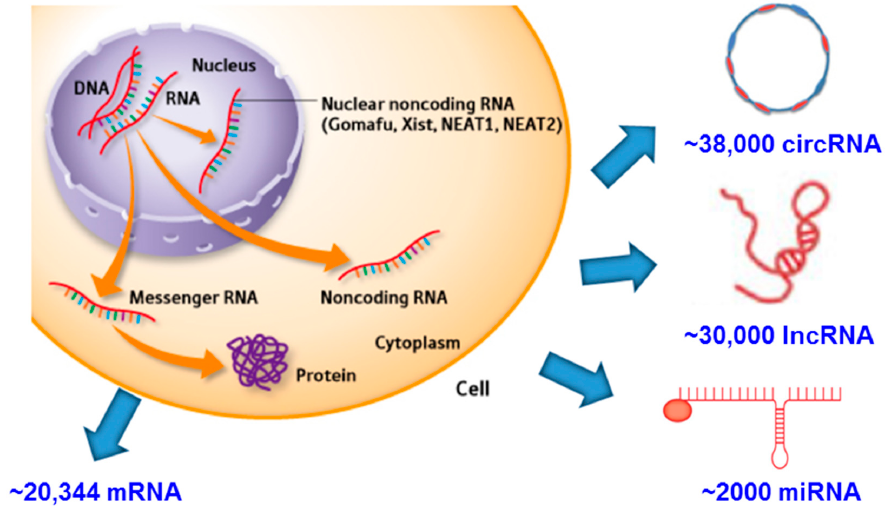
Figure 1. Current perspective of potential types of RNA in a hypothetical human cell. Prepared using information from [9–12].